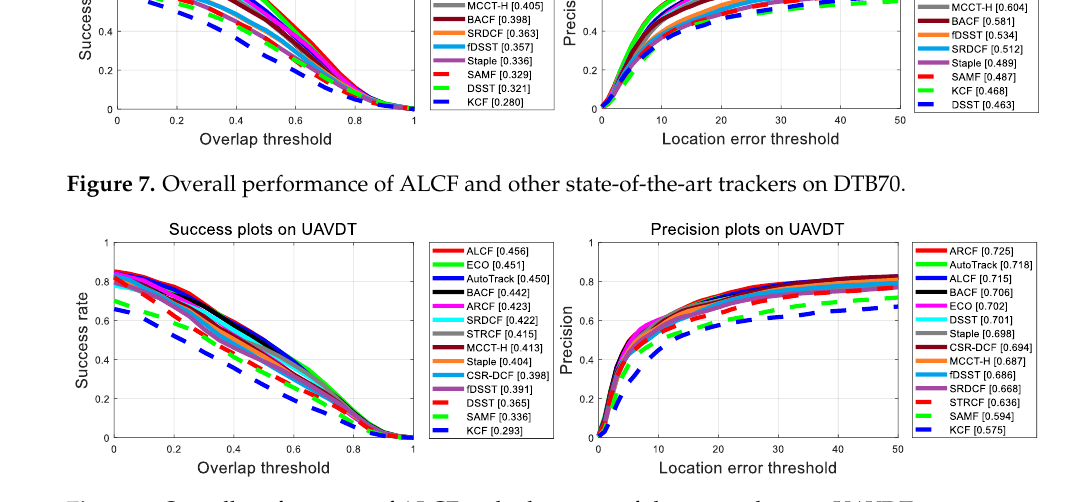
Figure 8. Overall performance of ALCF and other state-of-the-art trackers on